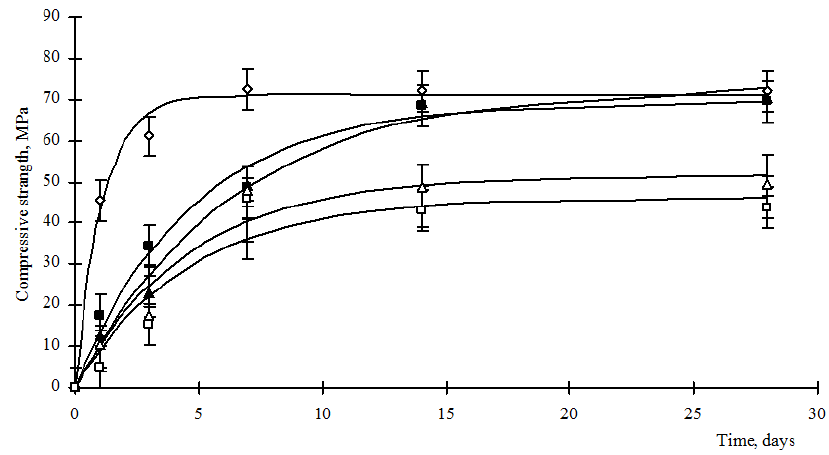
Figure 5. Strength of cement stone modified with barium hydrosilicates and copper hydrosilicates, where: ◊— control composition; ■ — content of hydrosilicates of copper 0.25%; ▲ — content of hydro- silicates of copper 0.50%; ∆— content of hydrosilicates of copper 0.75%; □— content of hydrosilicates of copper 1.0%.